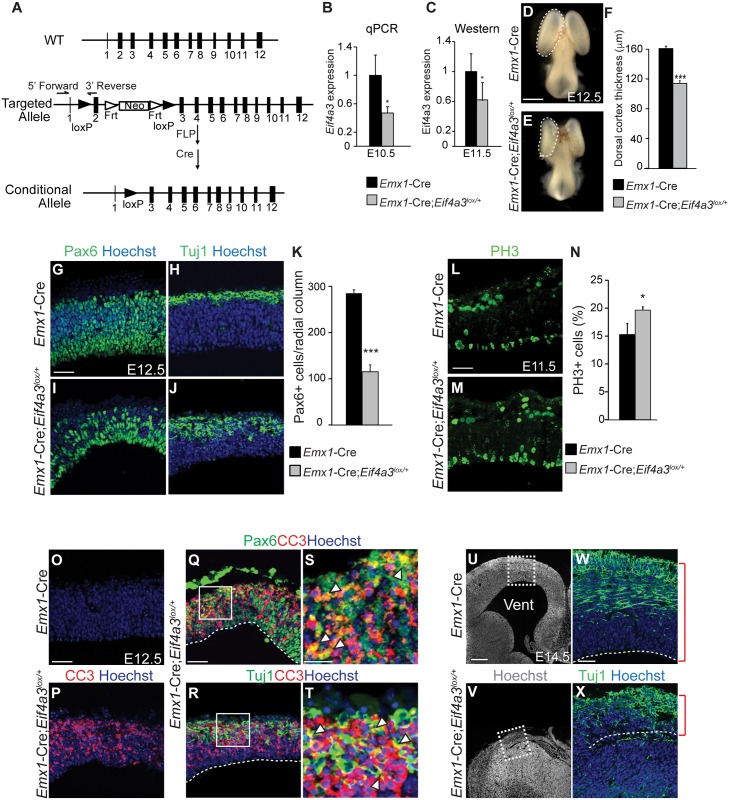
Eif4a3 is required for embryonic neurogenesis and brain size.(A) Top, Eif4a3 genomic mouse locus. Middle, targeted allele with 2 loxp sites (black arrowheads), Neo cassette, and 2 FRT sites (white arrowheads). Genotyping primers are indicated. Bottom, the conditional allele following FLP- and Cre-mediated recombination. (B) qPCR quantification of Eif4a3 mRNA levels in E10.5 neocortices, following normalization using Gapdh. Eif4a3 mRNA level of Emx1-Cre samples was set to 1.0. (C) Quantification of Eif4a3 protein levels in E11.5 dorsal cortices by densitometry of western blots, following normalization with α-Tubulin for loading. (D,E) Whole mount E12.5 Emx1-Cre and Emx1-Cre;Eif4a3lox/+ brains. Note the forebrain (dotted lines) is noticeably smaller in the Eif4a3 mutant. (F) Quantification of cortical thickness of E12.5 Emx1-Cre and Emx1-Cre;Eif4a3lox/+ dorsal neocortices. (G-J) 4 different coronal sections from E12.5 Emx1-Cre (G,H) and Emx1-Cre;Eif4a3lox/+ (I,J) neocortices stained for Hoechst (blue), Pax6 (green, G,I) or Tuj1 (green, H,J). (K) Density of Pax6+ cells within 200 μm wide radial columns spanning the E12.5 cortices of indicated genotypes. (L, M) Images of E11.5 Emx1-Cre (L) or Emx1-Cre;Eif4a3lox/+ (M) cortices stained for PH3 (green). (N) Graph depicting percentage of all cells which are PH3-positive for indicated genotypes at E11.5. (O-T) E12.5 coronal sections from Emx1-Cre (O) and Emx1-Cre;Eif4a3lox/+ brains (P-T) stained for Hoechst (blue), CC3 (red), Pax6 (green, Q, S), and Tuj1 (green, R,T). S and T are high-magnification views of Q and R, respectively, as indicated. Arrowheads depict cells co-labeled for apoptotic and cell fate markers. (U-X) Coronal sections of E14.5 Emx1-Cre (U,W) and Emx1-Cre;Eif4a3lox/+ (V,X) cortices stained for Hoechst (white or blue) and Tuj1 (green). W and X are high-magnification images of U and V, respectively as indicated. Red brackets denote cortical thickness. Vent, ventricle. Student’s t test, *, p<0.05, ***, p<0.001. Error bars, S.D. n = 3 biological replicates each. Scale bars, D, E, 1 mm; G-J, L,M,O-R, W, X, 50 μm; S,T, 20 μm; U,V, 200 μm.